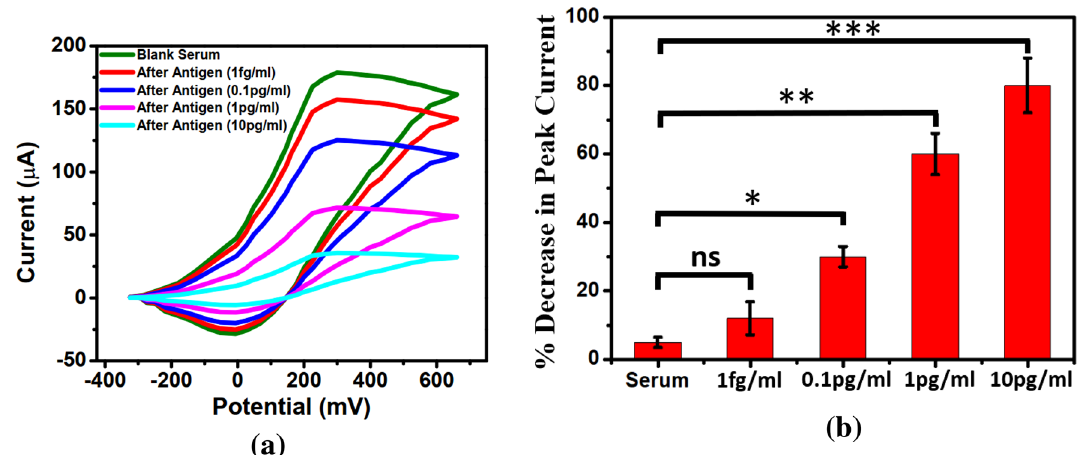
Figure 9. ( a ) CV in presence ofserum. ( b ) Percentage decrease in peak current with different CEA concentration in serum (ANOVA). Error bars represent the standard deviation (ns: p > 0.05 and * p < 0.01, ** p < 0.001, *** p <